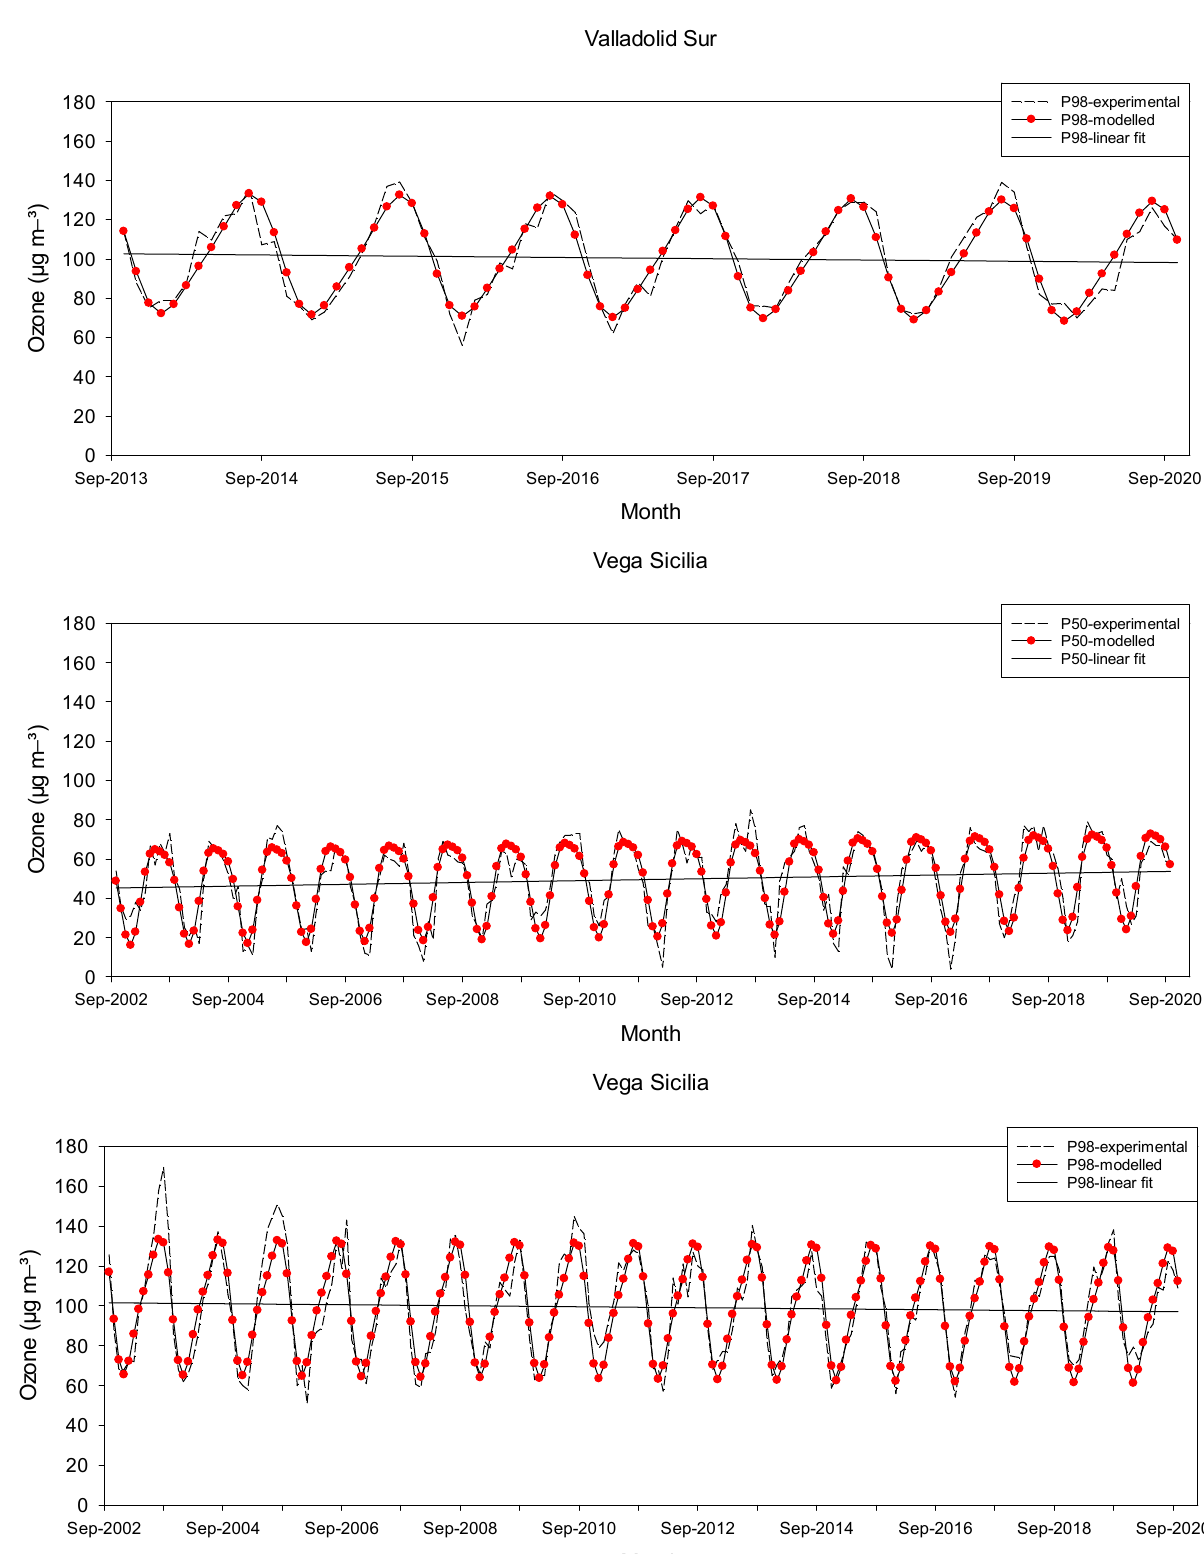
Figure 5. Evolution of the monthly ozone concentrations of the 50th percentile (P50) and 98th percentile (P98) in the study period.